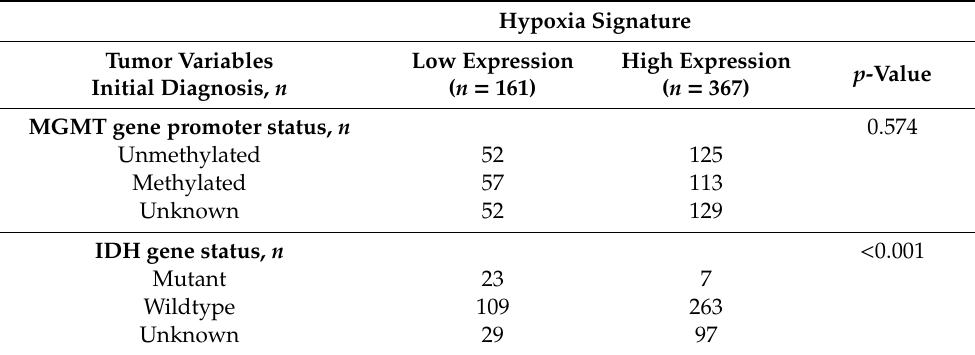
Table 2. The Cancer Genome Atlas (TCGA) patient